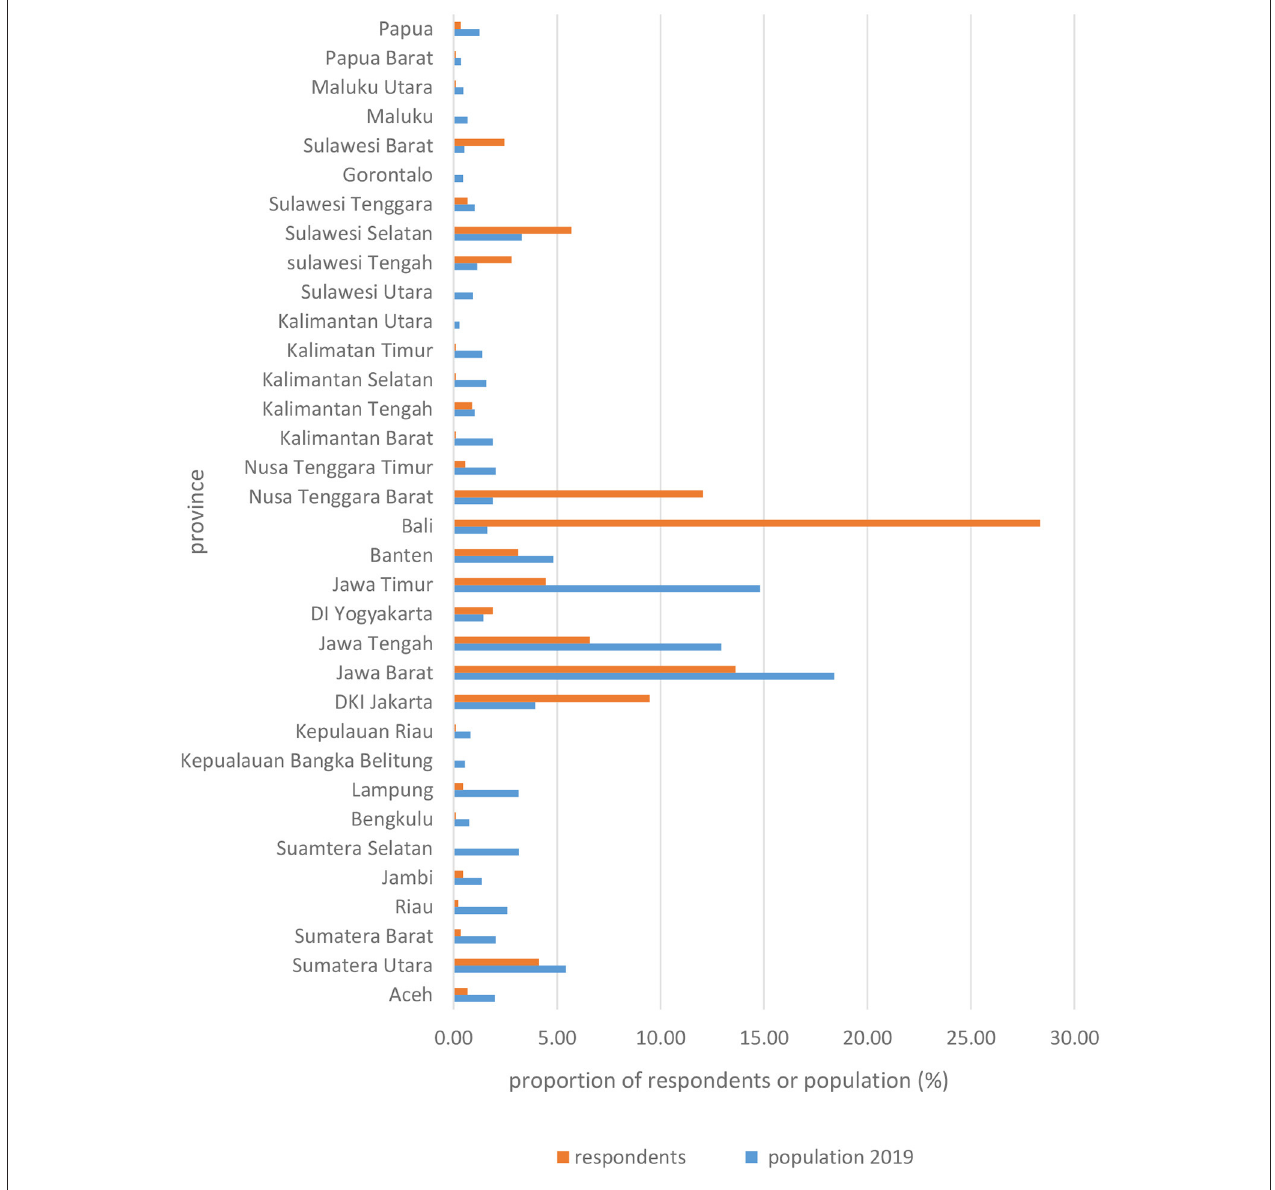
FIGURE 2 | Comparison between respondents and population distribution